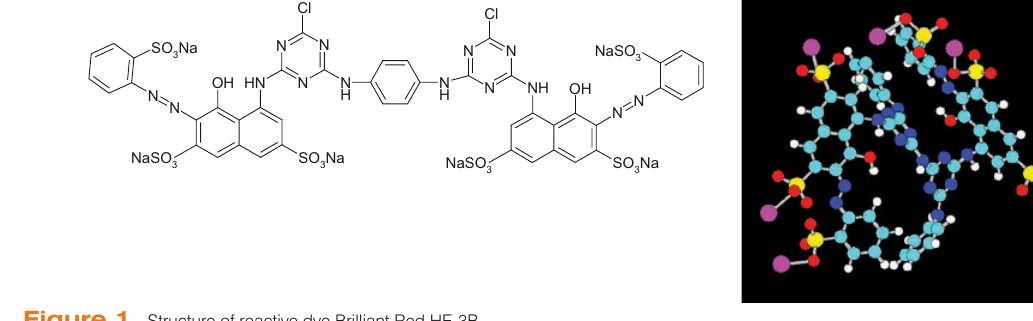
Figure 1. Structure of reactive dye Brilliant Red